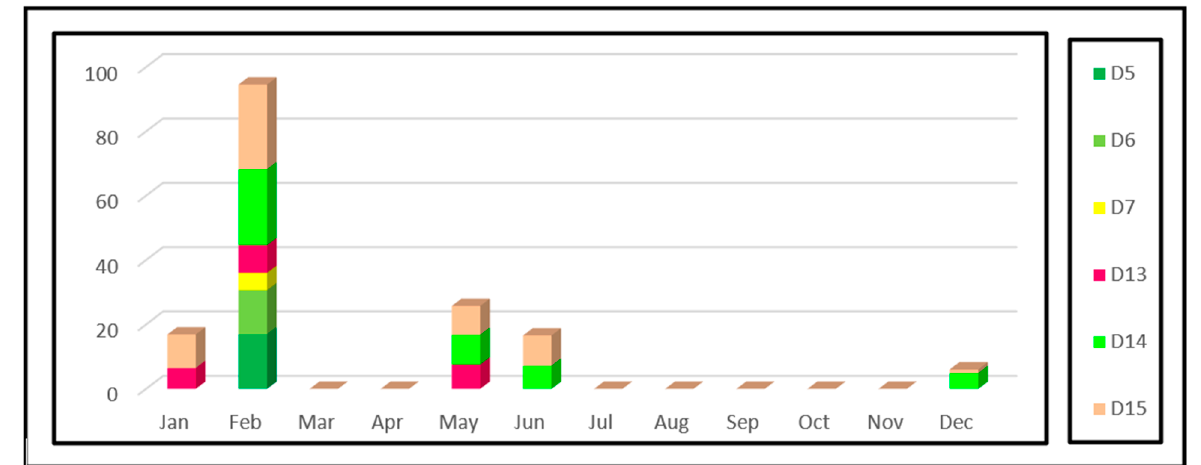
Figure 15. Monthly unmet demand (MCM) of lining four sections.